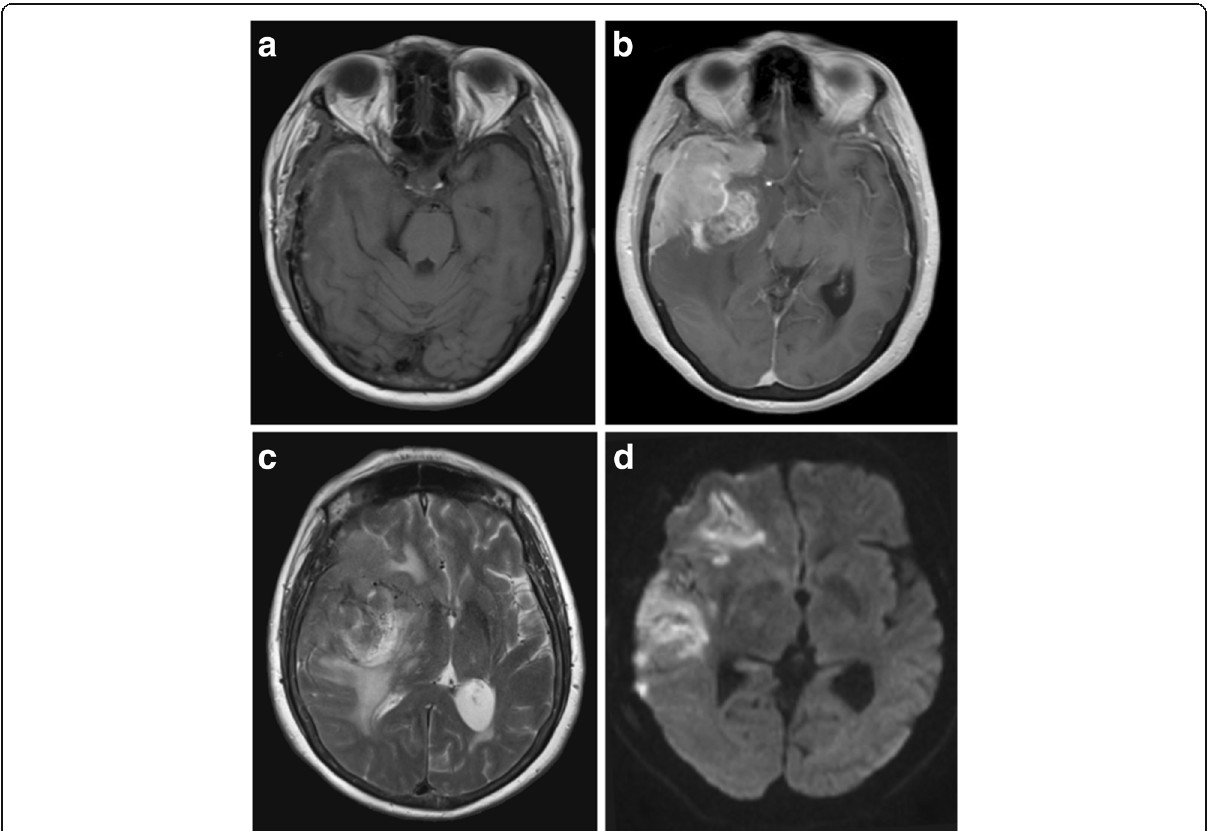
Fig. 3 Atypical meningioma. a , b Pre- and post-contrast axial T1-weighted MR images showing a heterogeneously enhancing mass with a wide dural bass, dural tail and CSF cleft. The cortical interface is poorly outlined suggestive invasion of the underlying brain parenchyma as well as the adjacent skull. c Axial T2-weighted MR image of the same lesion with surrounding vasogenic oedema and midline shift. d A diffusion-weighted image shows heterogeneous areas of restricted diffusion extending into the adjacent